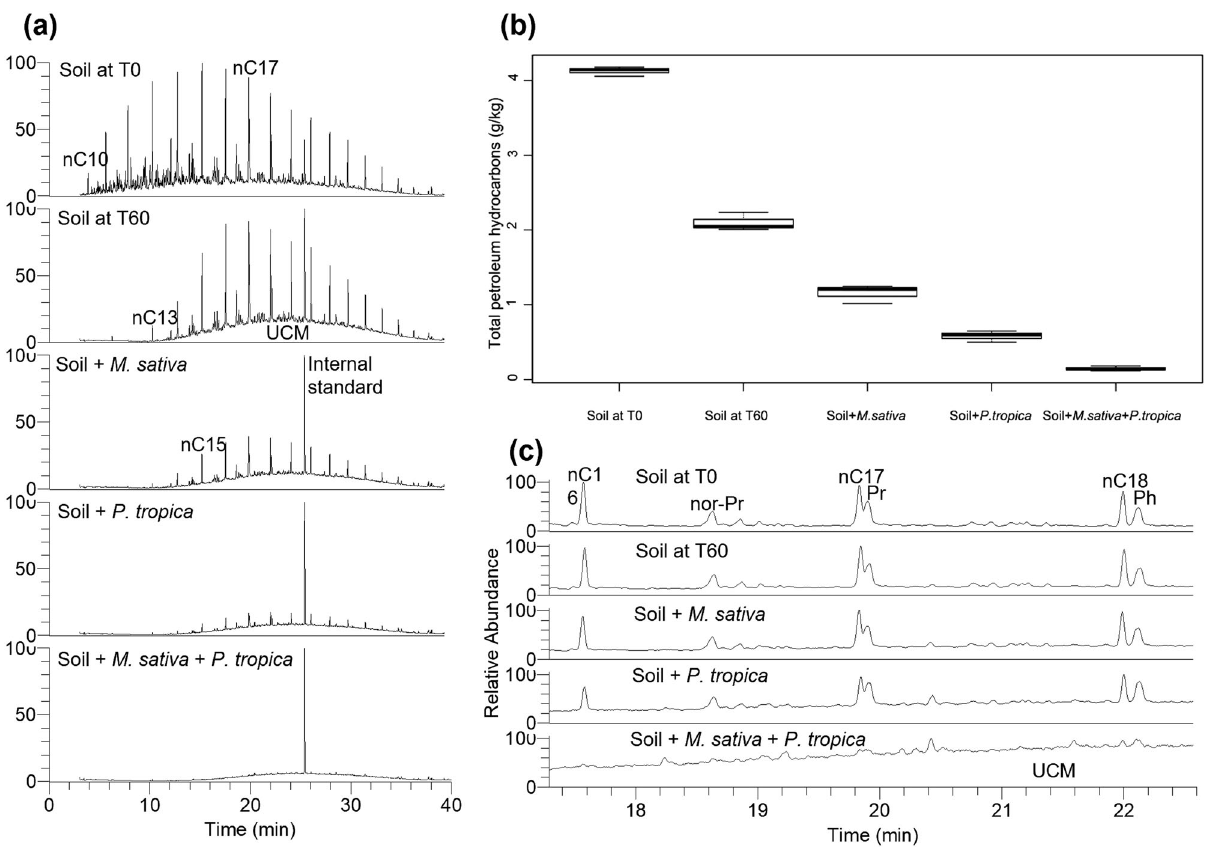
Fig. 2 Enhanced degradation of diesel fuel hydrocarbons resulting from bacteria inoculation. a GC – MS chromatograms (total ion current) showing the initial total hydrocarbons in the contaminated soils and the residual hydrocarbons after 60 days under different treatments. The chromatograms are normalized to sample weight and can be directly compared with reference to the internal standard peak (the same amount was added to all samples). b Boxplot showing the mean values of residual total petroleum hydrocarbons for the different treatments. c Partial total ion chromatograms showing preferential biodegradation of nC 16 , nC 17 and nC 18 relative to nor-pristane (nor-Pr), pristane (Pr), and phytane (Ph) with increasing biodegradation among the different treatments. “ Soil at T0 ” : contaminated soils at the beginning of experiment; “ Soil at T60 ” : unplanted and uninoculated (control) soils after 60 days; “ Soil + M. sativa ” : soils planted with M. sativa ; “ Soil + P. tropica ” : soils inoculated with P. tropica ; “ Soil + M. sativa + P. tropica ” : soils planted with M. sativa and inoculated with P. tropica ; UCM unresolved complex mixture.